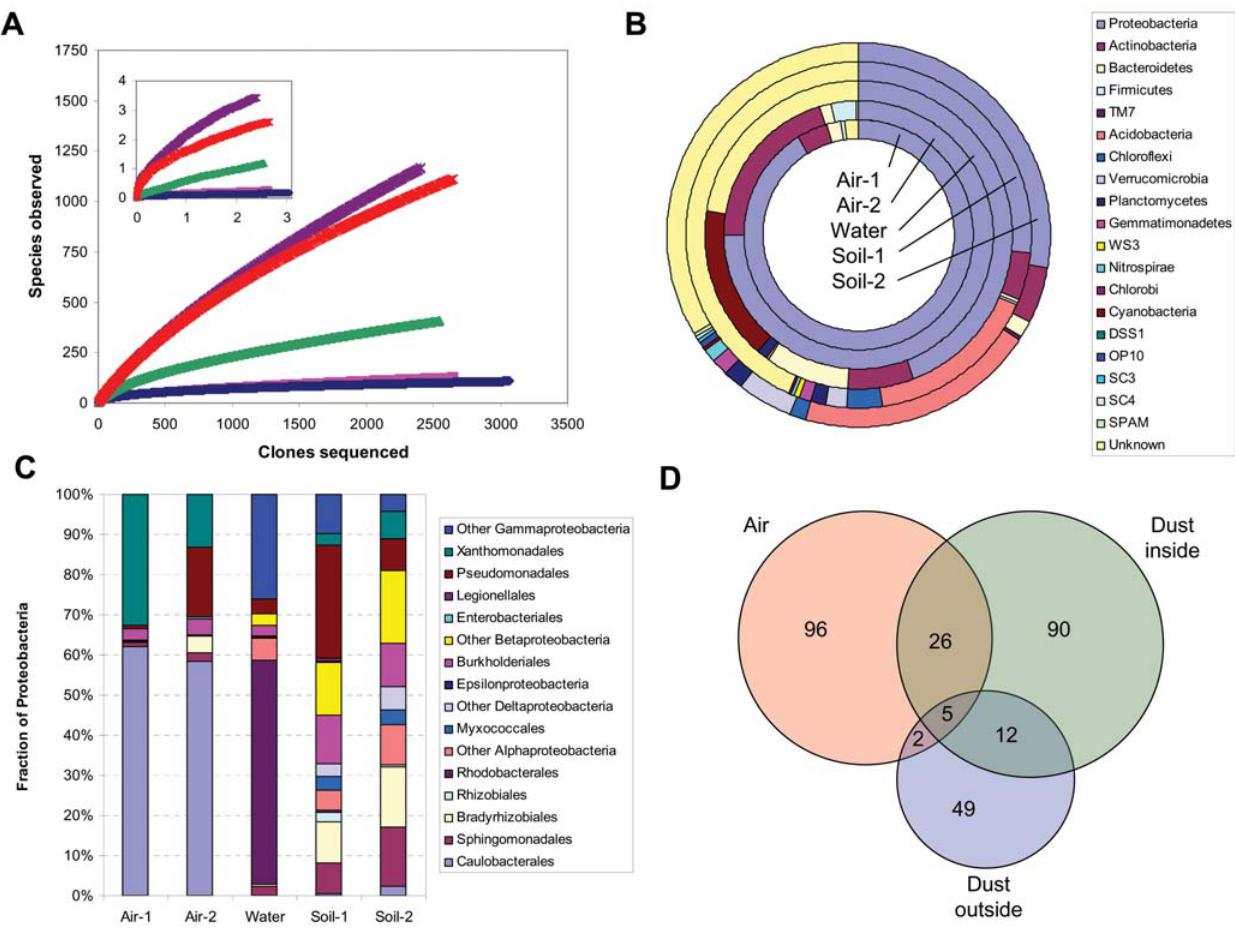
Figure 2. Microbial diversity in air and other local environmental samples. A. Rarefaction curves of observed phylotype diversity for Air-1 (pink line), Air-2 (dark blue), water (green), Soil-1 (purple), and Soil-2 (red). The similarity threshold is 97%. Inset: the estimated diversity in the 5 samples using the Chao1 richness estimator. B. Distribution of microbial divisions in each of the environmental samples; circles represent, from the inside out, Air-1, Air-2, Water, Soil-1, and Soil-2. C. Bacterial orders within the Proteobacteria for each sample. D. A Venn diagram of all phylotypes observed in the air and dust samples from location 2.